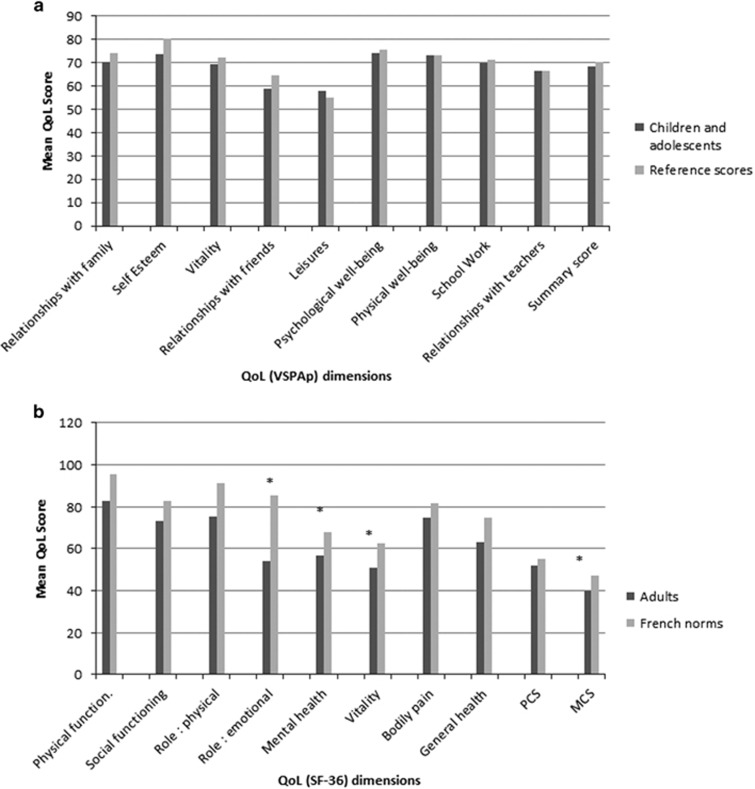
HRQoL results of the L.E.A. cohort relative to sex-and age-matched French norms (available for age >7 years) according to VSPAp (a) and SF-36 (b) questionnaires. *P<0.05 paired Student's t-tests for age and sex (n=57) with the French population reference group. PCS, Physical Composite Score; MCS, Mental Composite Score.